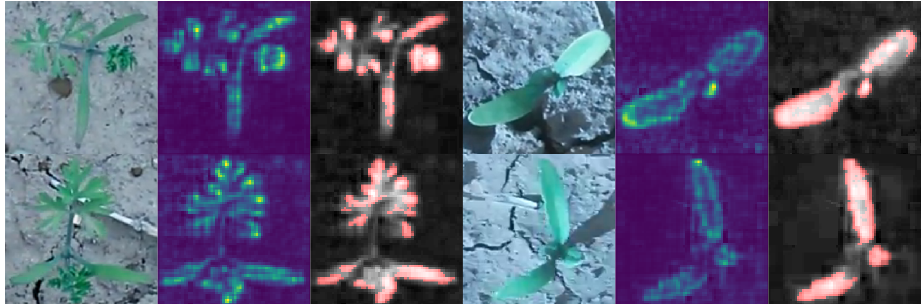
Figure 8. Layer-wise relevance propagation result for both data sets. For each example, the original RGB image ( left ), the LRP result ( center ) and the result of the statistical test for the saliency maps ( right ) is visualized. The results show that the CNN was able to focus on the plant leaf shape and architecture.